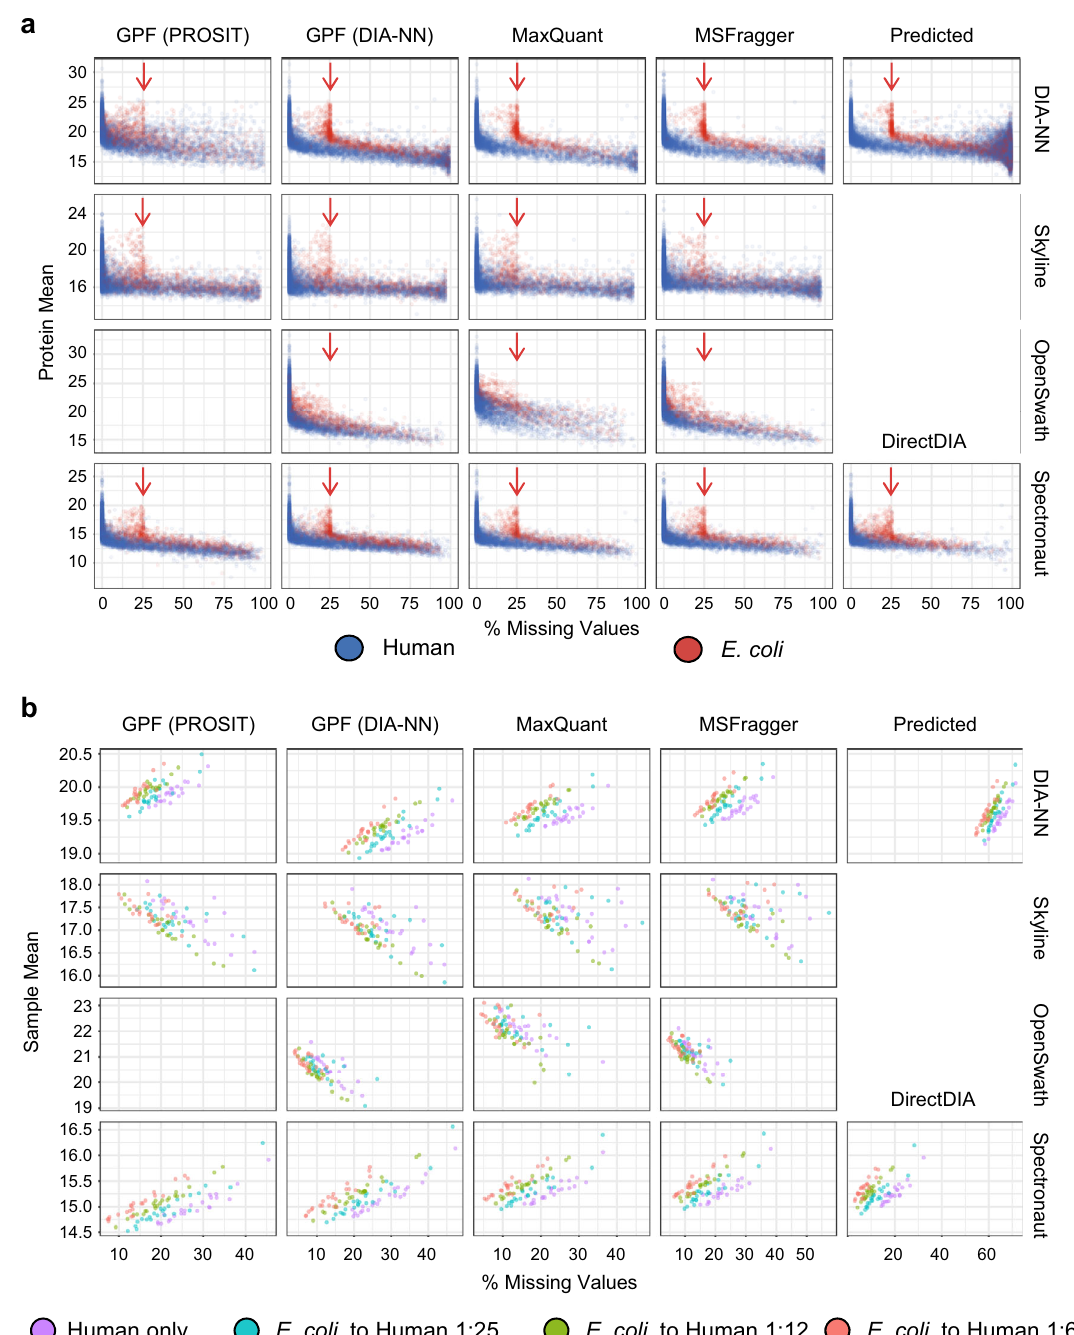
Fig. 3 Missing value characteristics and correlations at the protein level. a The way small intensities are handled mainly depends on the employed DIA software. Means of log2 intensities of identi fi ed human (blue) and E. coli (red) proteins plotted against the percentage of missing values in the respective protein. E. coli proteins are not physically present in 25% of samples (indicated by the red arrow). b The correlation between the missingness within samples and the sample mean over all proteins of these samples varies with the employed DIA software. Sample means are plotted against the percentage of missing values in the respective different statistical tests. For sparsity reduction we applied: (a) no sparsity reduction (NoSR), (b) requiring >66% values per protein (SR66), and (c) requiring >90% values per protein (SR90). Four different methods were then applied to investigate the effect of normalization: (a) unnormalized, (b) quantile normalization (QN), (c) tail-robust quantile normalization (TRQN), and (d) median normalization. Finally, we used the following seven statistical tests to probe for differentially abundant proteins: